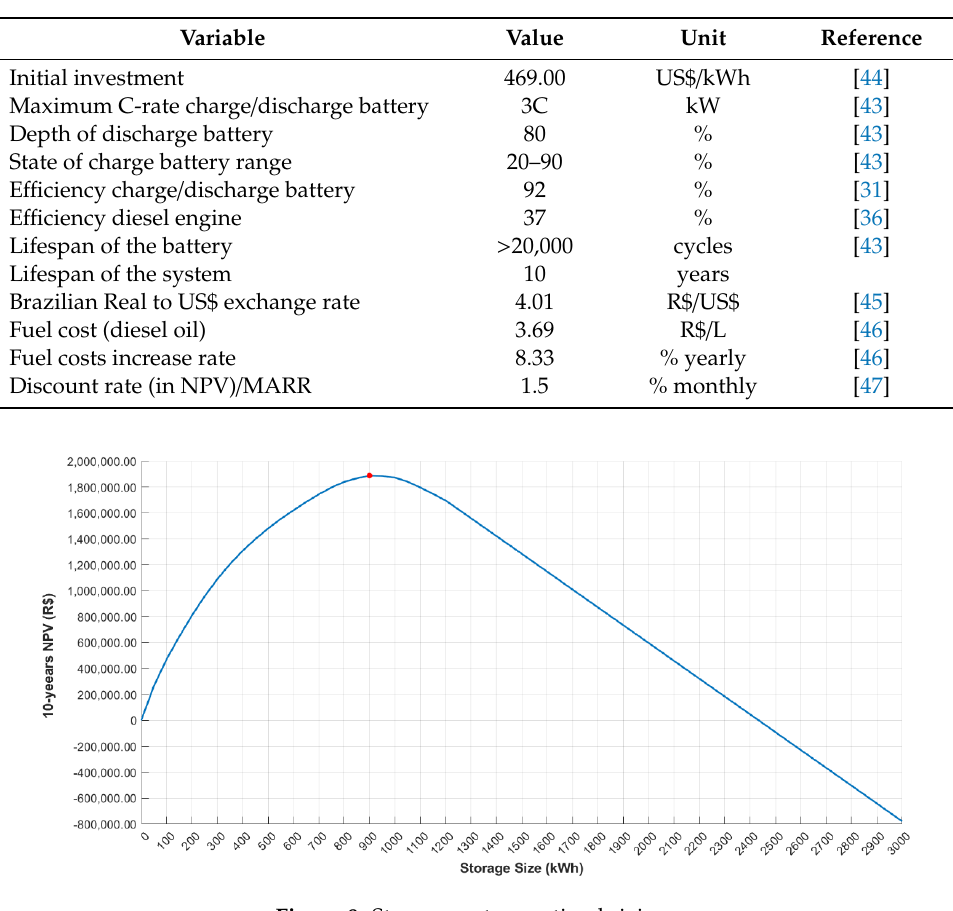
Table 5. Input data to model the optimal size of the storage system.